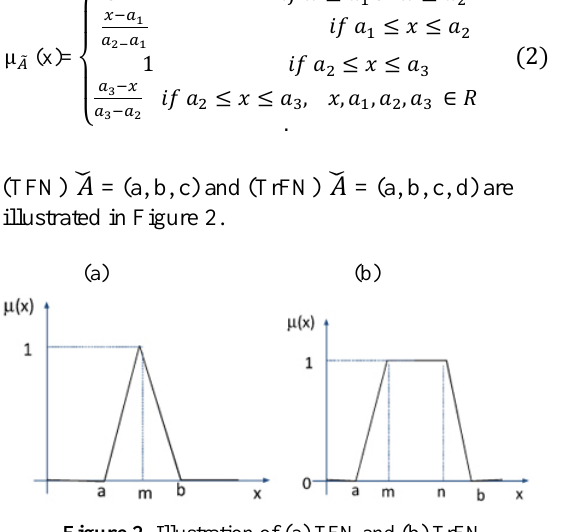
Figure 2. Illustration of (a) TFN and (b)